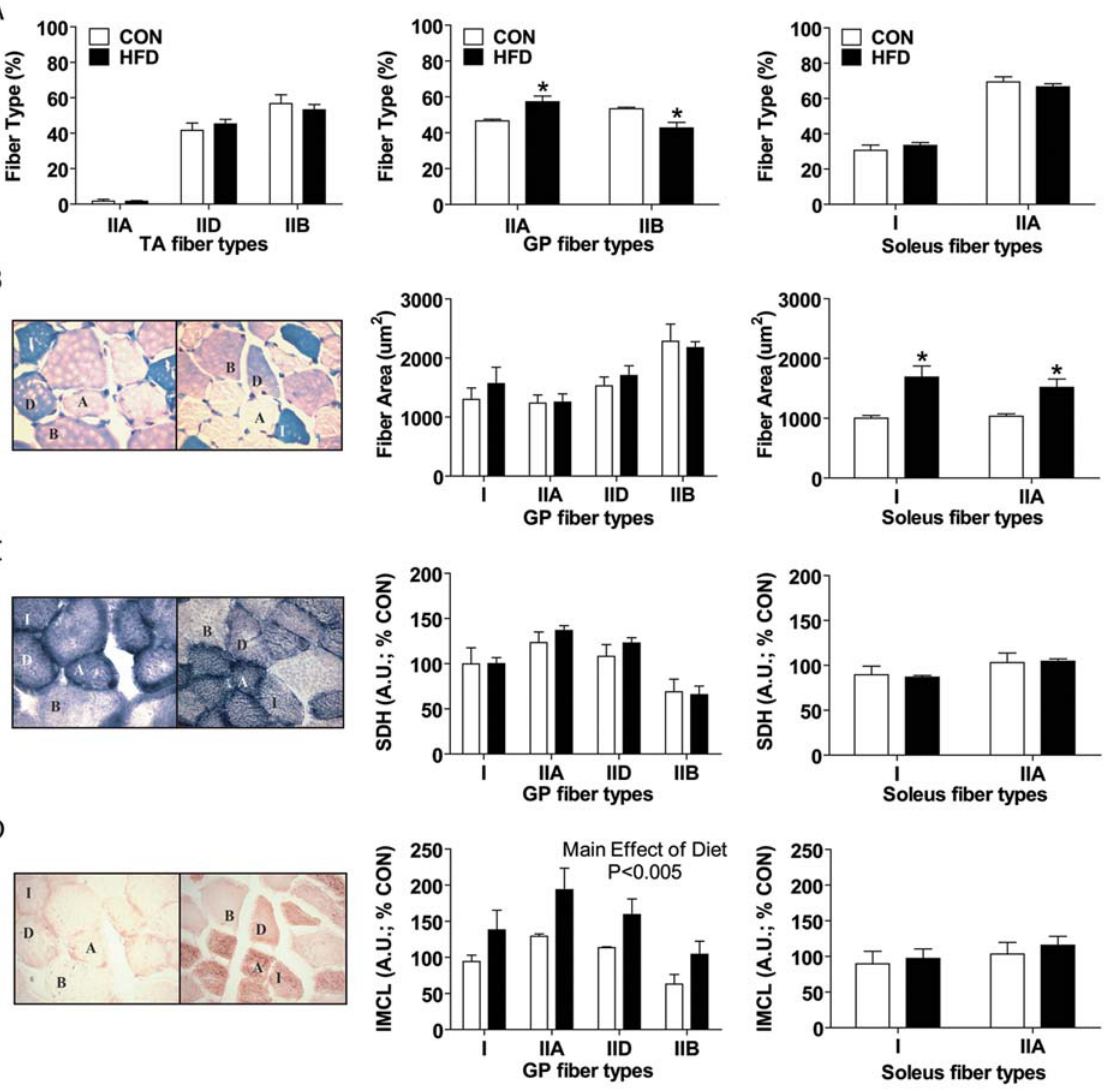
Figure 2. Morphometric changes are muscle-specific. Serial cross-sections from control (CON, white bars in all graphs) and high fat diet (HFD, black bars in all graphs) fed mouse muscles [TA (top left only), gastrocnemius/plantaris complex (GP, all middle graphs), and soleus (all right graphs)] were examined for (A) fiber type composition, (B) area, (C) SDH stain intensity, and (D) IMCL stain intensity. Representative images of all stains used, performed on GP muscle cross-sections are shown to the left of graphs B–D with fiber type (type I, and types II- A, D, B) labeled with CON on the left and HFD on the right. (B) Metachromatic fiber type stain was used to assess fiber type. (C) SDH and (D) Oil-Red-O stains are graphically represented by arbitrary units (A.U.) of optical intensity measurements, with greater values for more intense stains and normalized to a percentage of all the control value means for each graph (% CON). All measurements were taken on an average of 51–331 total fibers/animal with a Nikon Eclipse 90i microscope (N=3–4). Significance is represented by * vs. CON, p ,